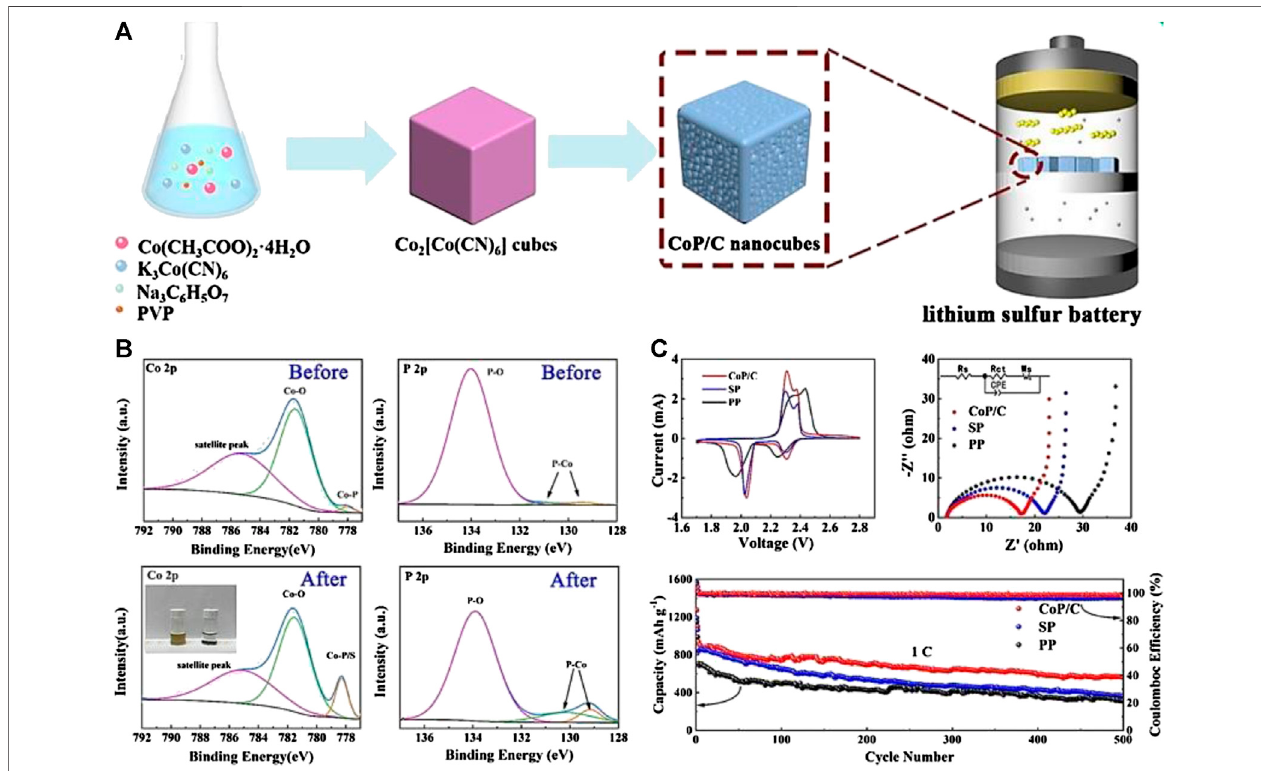
FIGURE 5 | (A) Schematic illustration of fabrication procedure of CoP/C nanocube and cell con fi guration of the LSBs employing the CoP/C coated separator (B) High-resolution XPS spectrum of Co 2p and P 2p before and after CoP/C interacting with Li 2 S 6 (C) Performance comparison of LSBs with different separators. Reproduced with permission from (Lin et al.,